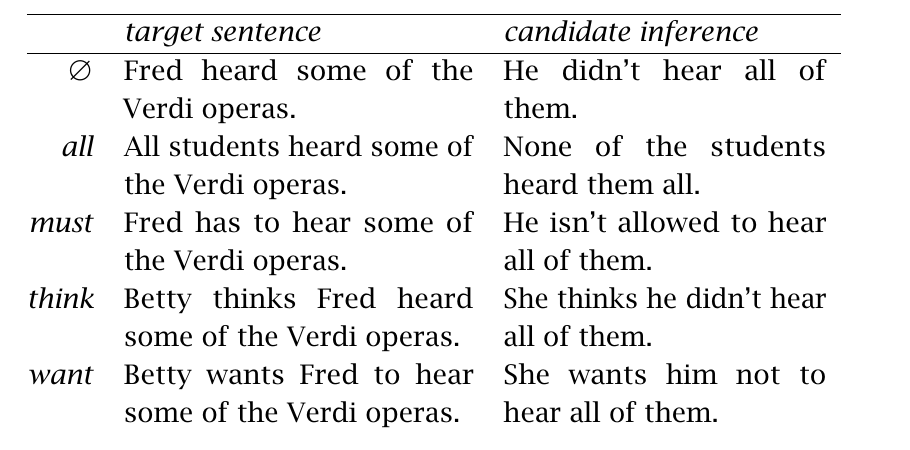
Table 1 : Sample sentences used in Experiments 1